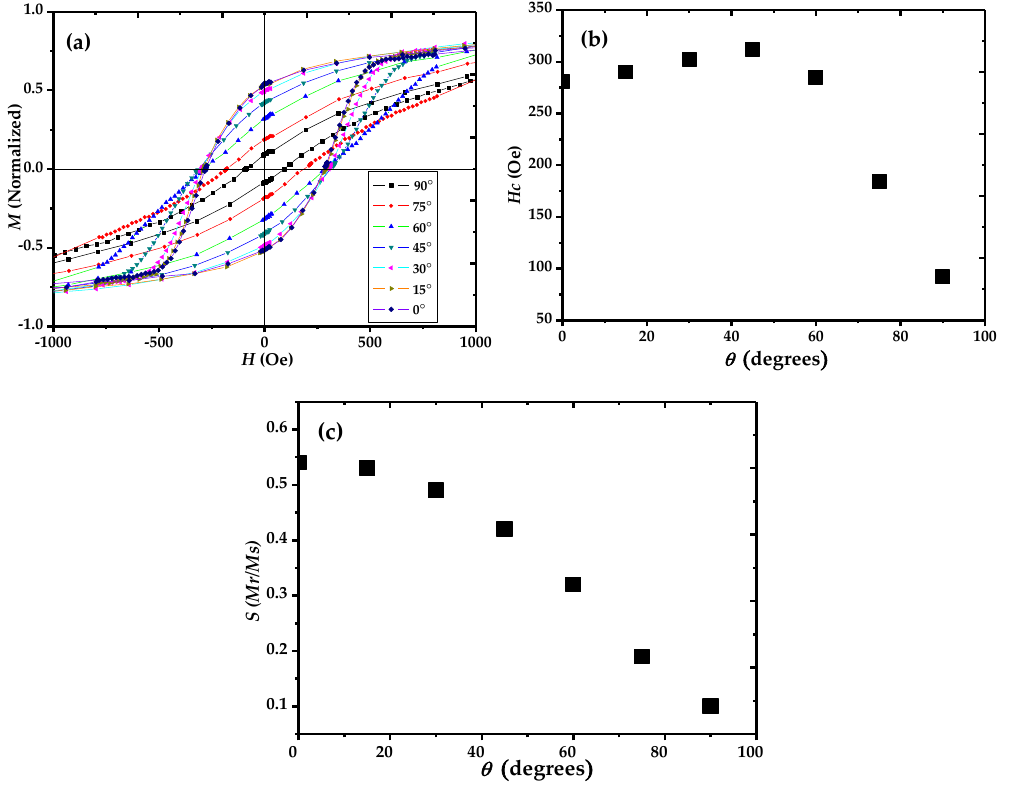
Figure 3. Angular dependence of ( a ) hysteresis loops ( b ) coercivity and ( c ) remanence squareness of Ni nanotube arrays, where θ is the angle between the applied field direction and the tube’s axis.